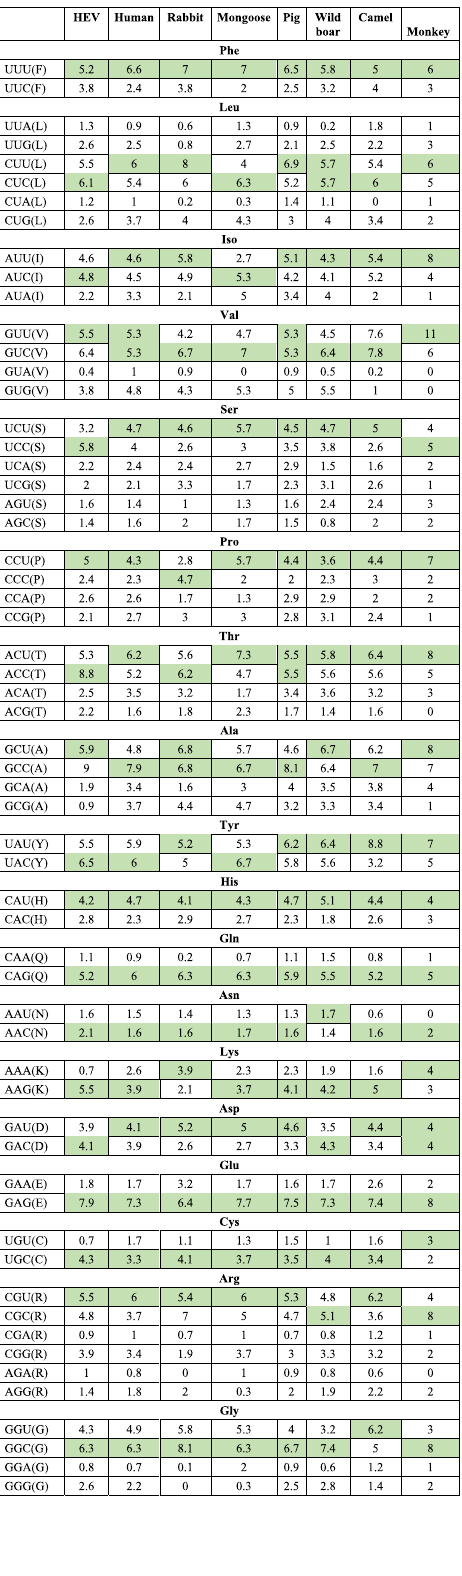
Table 3 Preferred codons for each amino acid in the YDR of HEV and its